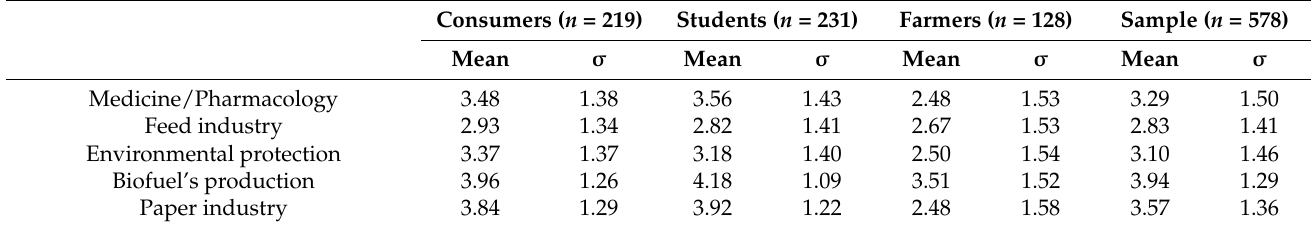
Table 4. The level of acceptance for non-food uses of